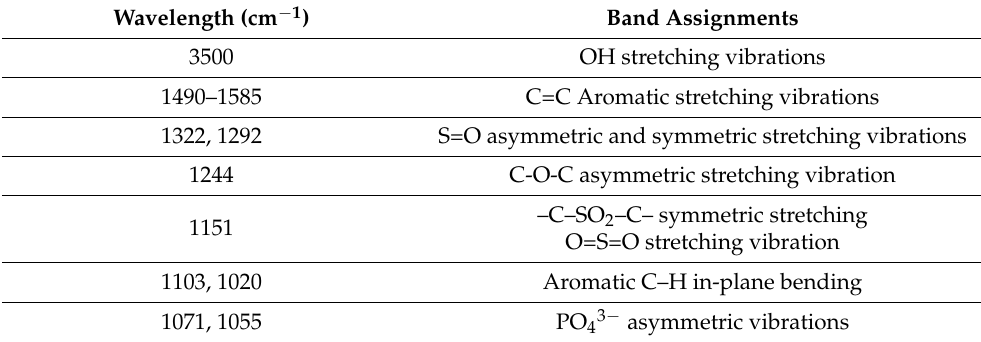
Table 1. Band assignment of FTIR spectra for the PSF/HA